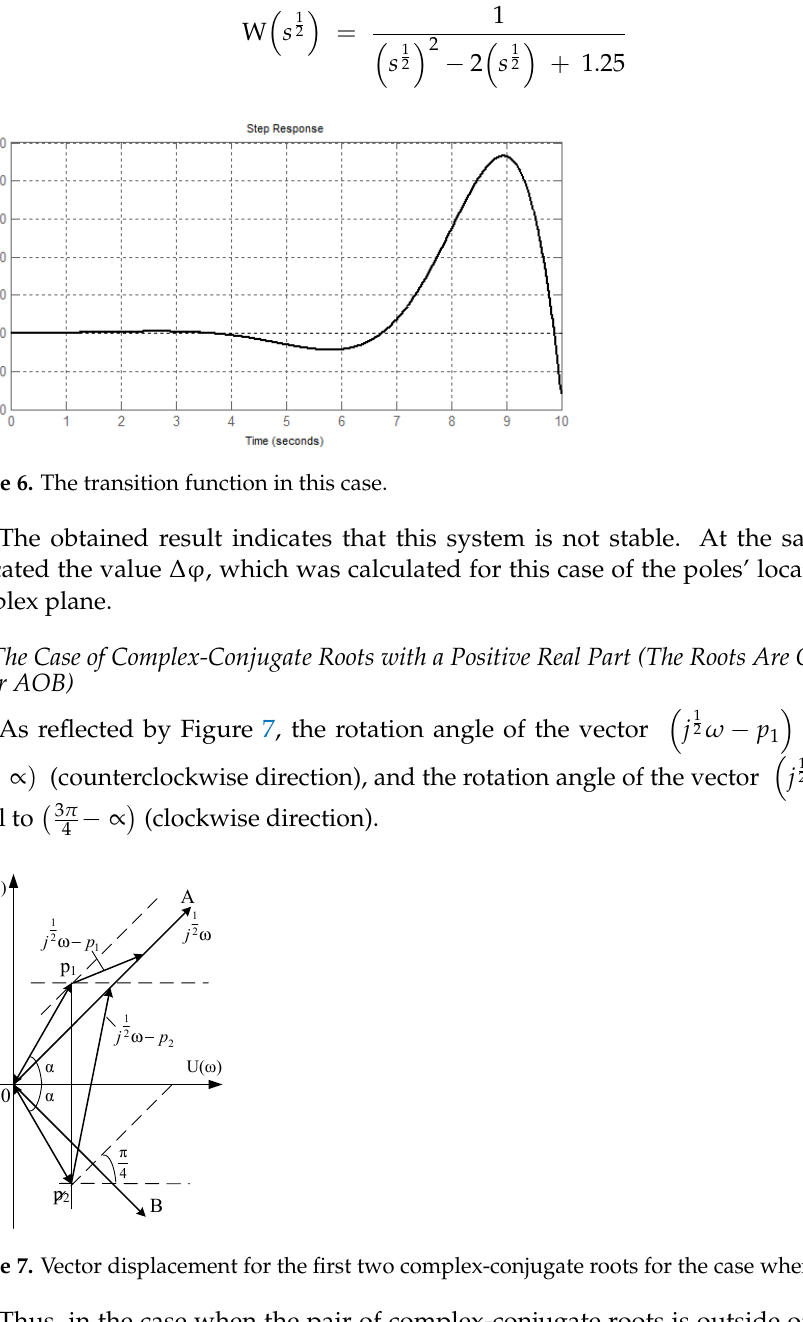
Figure 5. Vector displacement for the first two complex-conjugate roots for the case when 𝜔 𝜖 (0, ∞) .